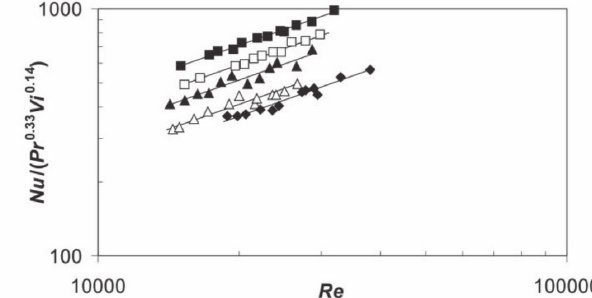
Fig. 6 – The dependence Nu/(Pr 0.33 Vi 0.14 ) = f(Re) for 30 % aqueous solution of glucose (w = 5.1 · 10 –3 m s –1 ) and differ­ og ent positions of the dimensionless axial coordinate z/H; lower impeller – A 315, upper impeller – RT,  – z/H= 0.07; D – z/H = 0.16;  – z/H = 0.42;  – z/H = 0.67; ▲– z/H = 0.82; ex­ perimental points obtained using thermal method